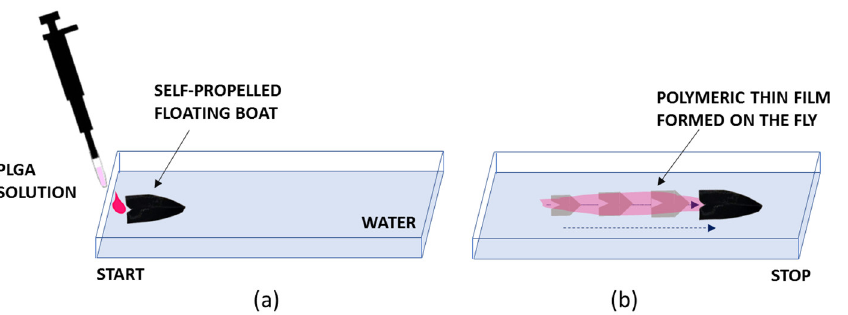
Figure 3. Scheme illustrating the mechanism of self-propulsion by the solute capillary Marangoni flow. ( a ) Dispensing of the polymeric solution for propelling the object (a black boat). ( b ) Propulsion of the object and simultaneous formation of a polymeric film along the direction of the propulsion. The object while moving over the water surface activates the formation of a thin film by polymer spreading on the water surface.